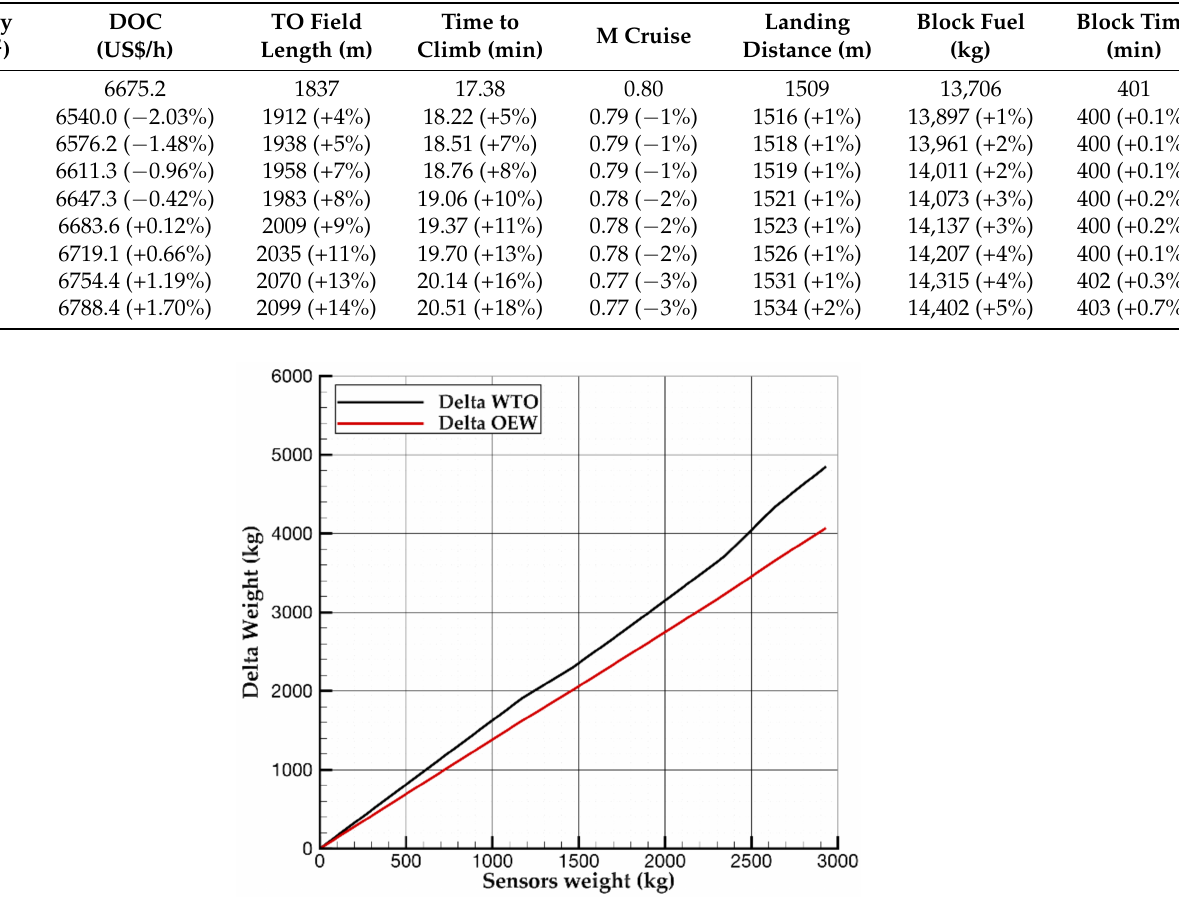
Table 17. Aircraft performance and DOC at different sensors density for the design mission (see Table 12).